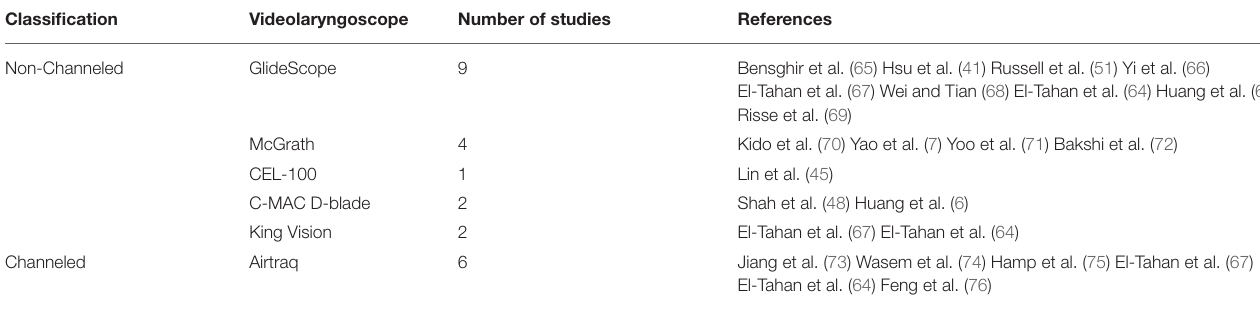
TABLE 1 | Randomized controlled trials on videolaryngoscope vs. the Macintosh laryngoscope for double lumen tube intubation.